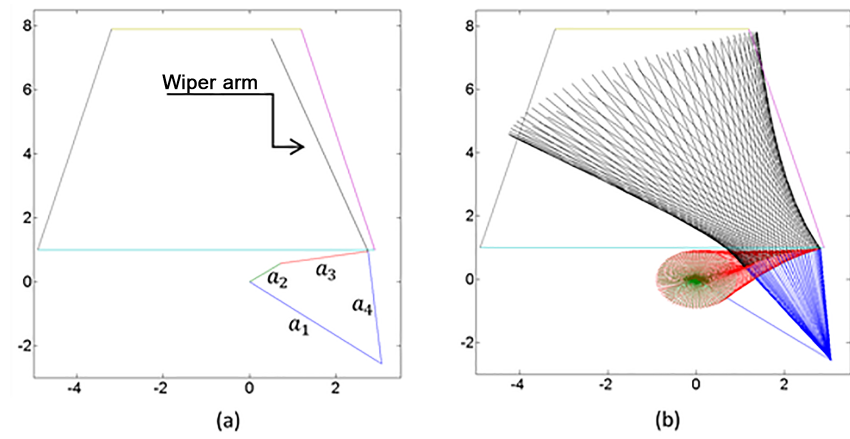
Figure 5. (a) Orientation of the mechanism, and (b) swept area (to scale).